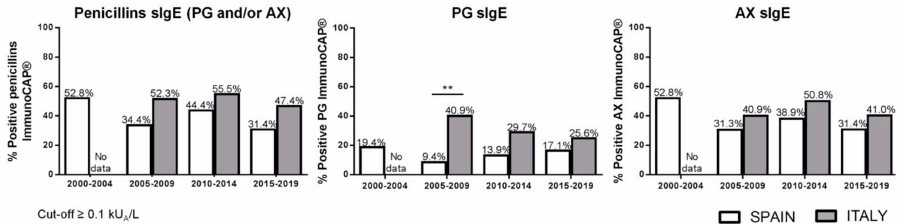
Figure 1. Percentage of patients with positive specific IgE (sIgE) to penicillin G (PG) and/or amoxi- cillin (AX) in Spanish and Italian groups. Significant differences if p ≤ 0.05: ** p < 0.01.